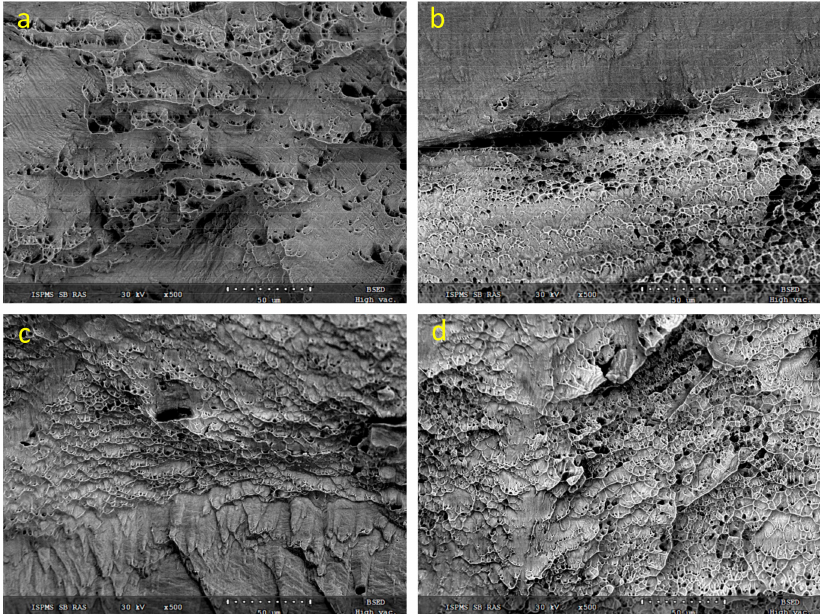
Figure 15. The SEM images of fracture surface of printed sample 1 ( a ), sample 2 ( b ), sample 3 ( c ) and sample 4 ( d